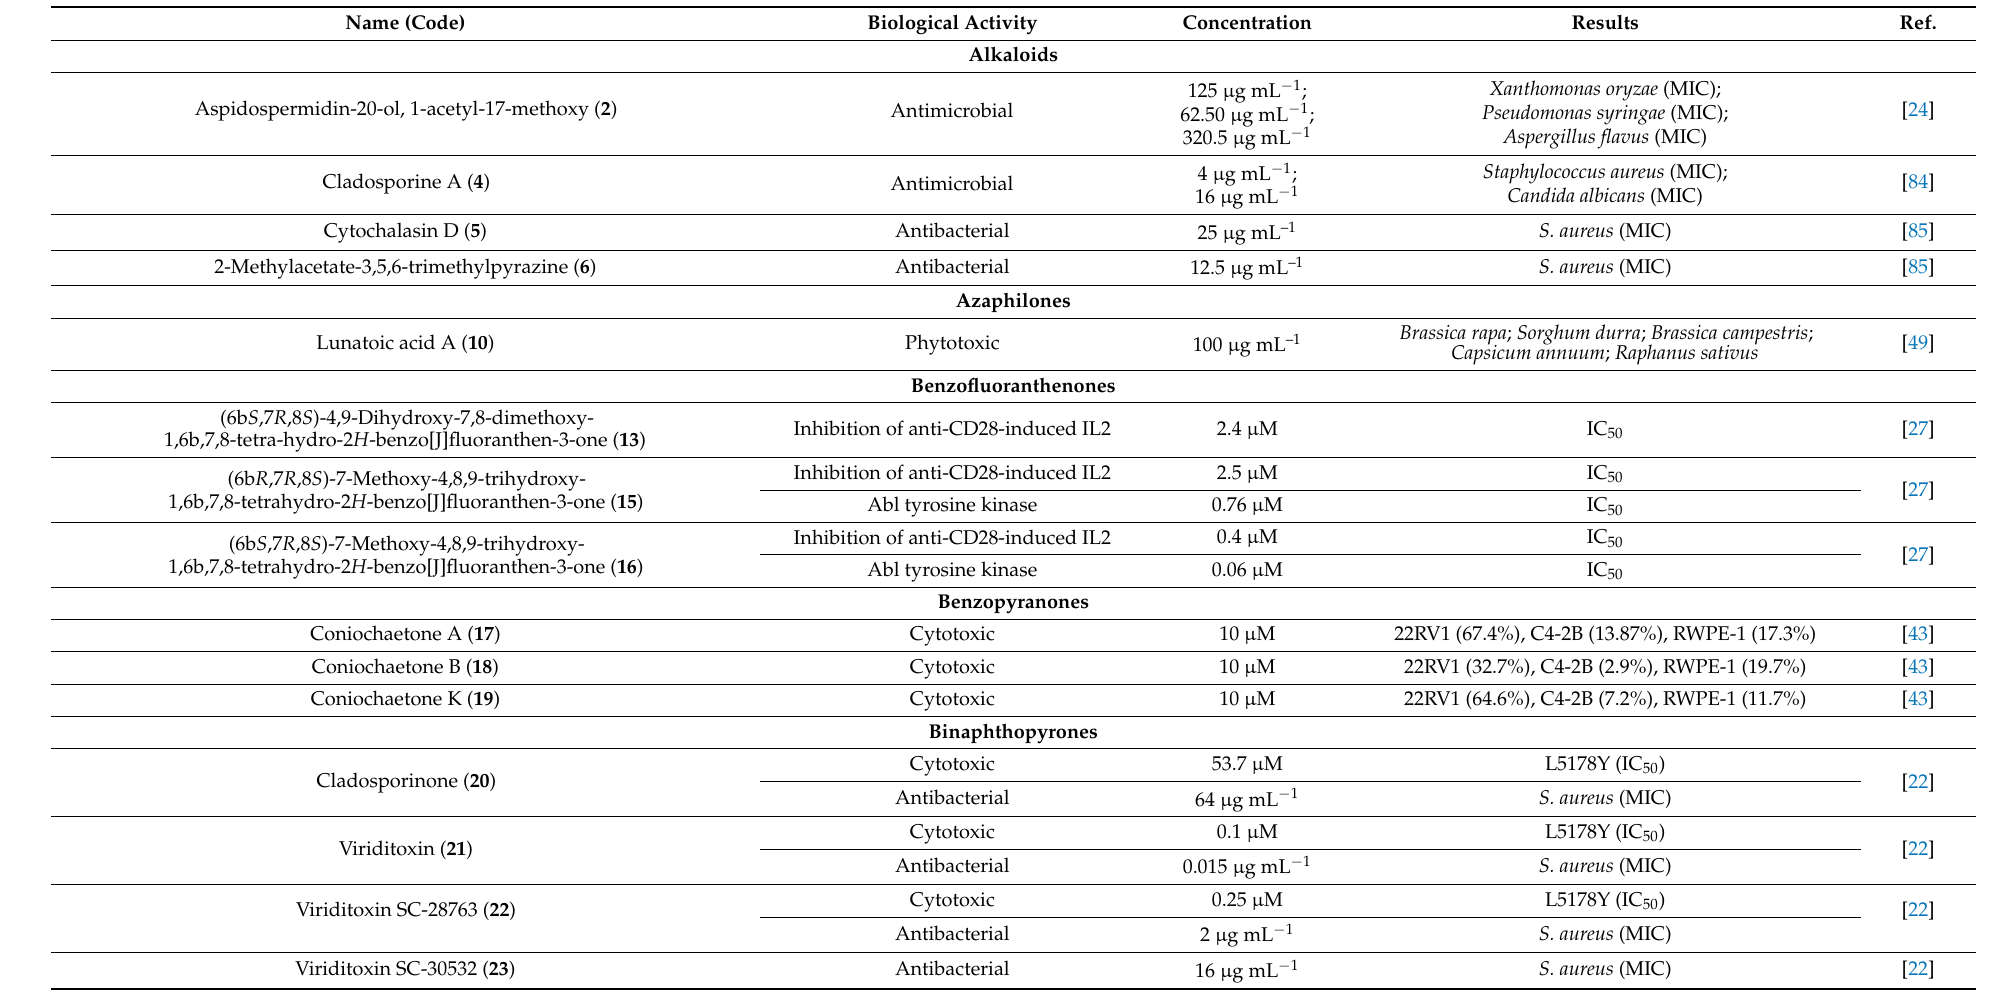
Table 3. Bioactivities of secondary metabolites produced by the Cladosporium